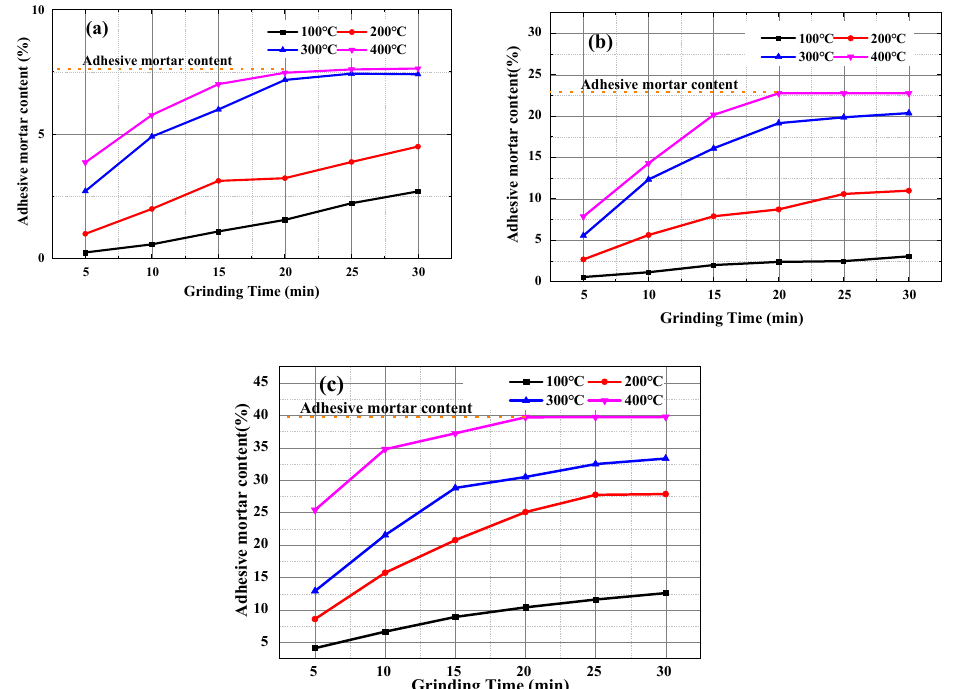
Figure 11. Contents of mortar attached to different quality recycled coarse aggregates. ( a ) Class I recycled coarse aggregate; ( b ) Class II recycled coarse aggregate; ( c ) Class Ш recycled coarse aggregate.